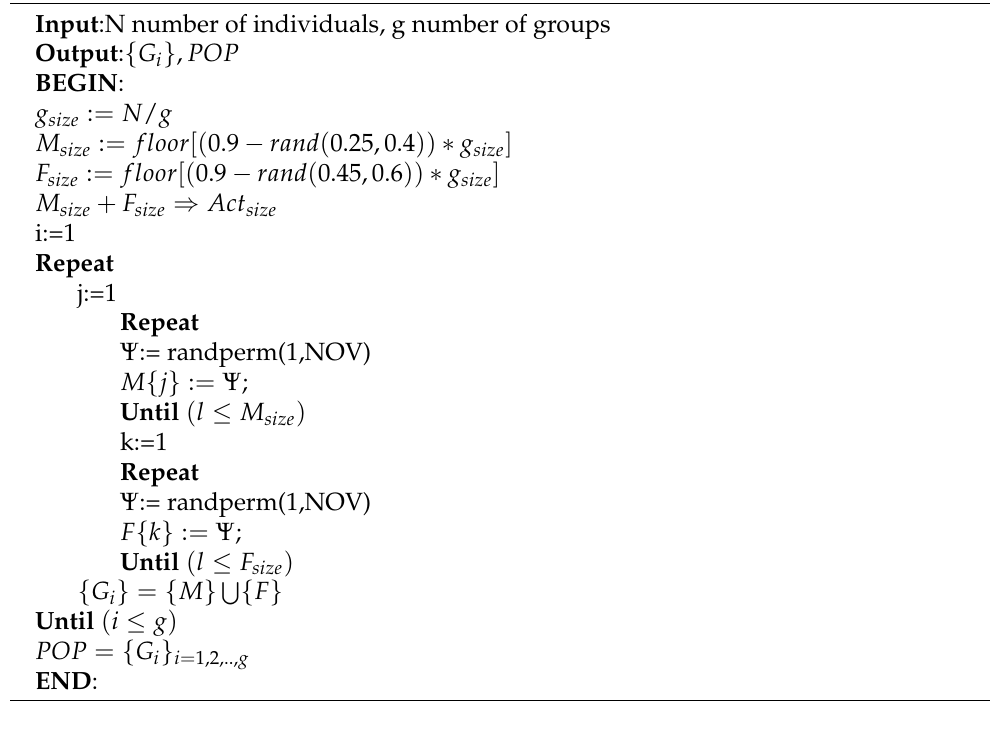
Algorithm 1 Initialization.